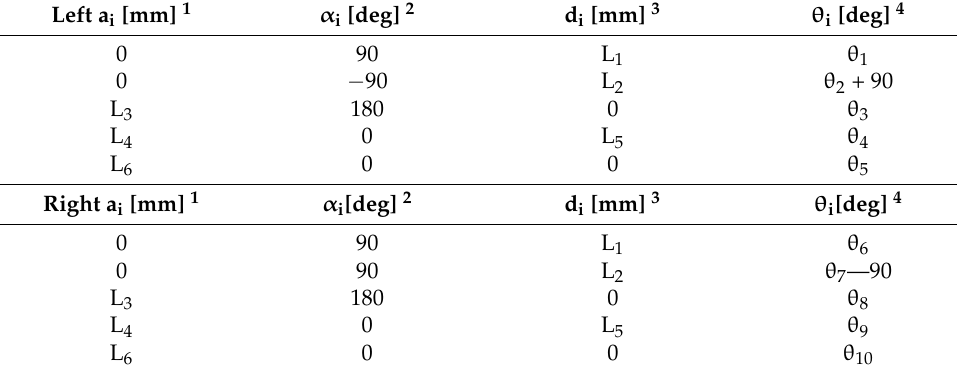
Figure 6. DH parameterization of the right (R) and the left (L) legs. Table 3. DH parameters of the robot kinematic model.